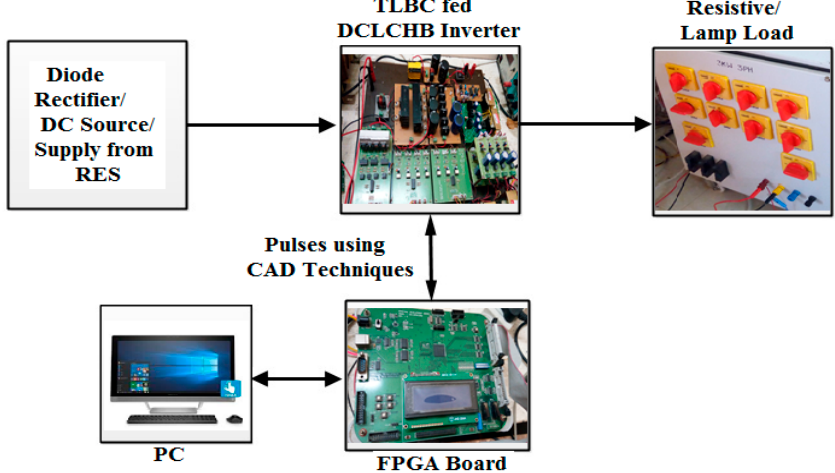
Figure 22. Block diagram of the TLBDCLCHB hardware implementation.